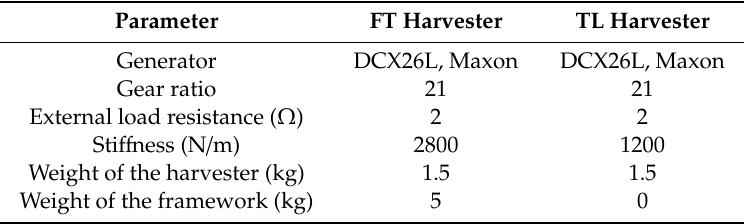
Table 2. Parameters of the prototypes.